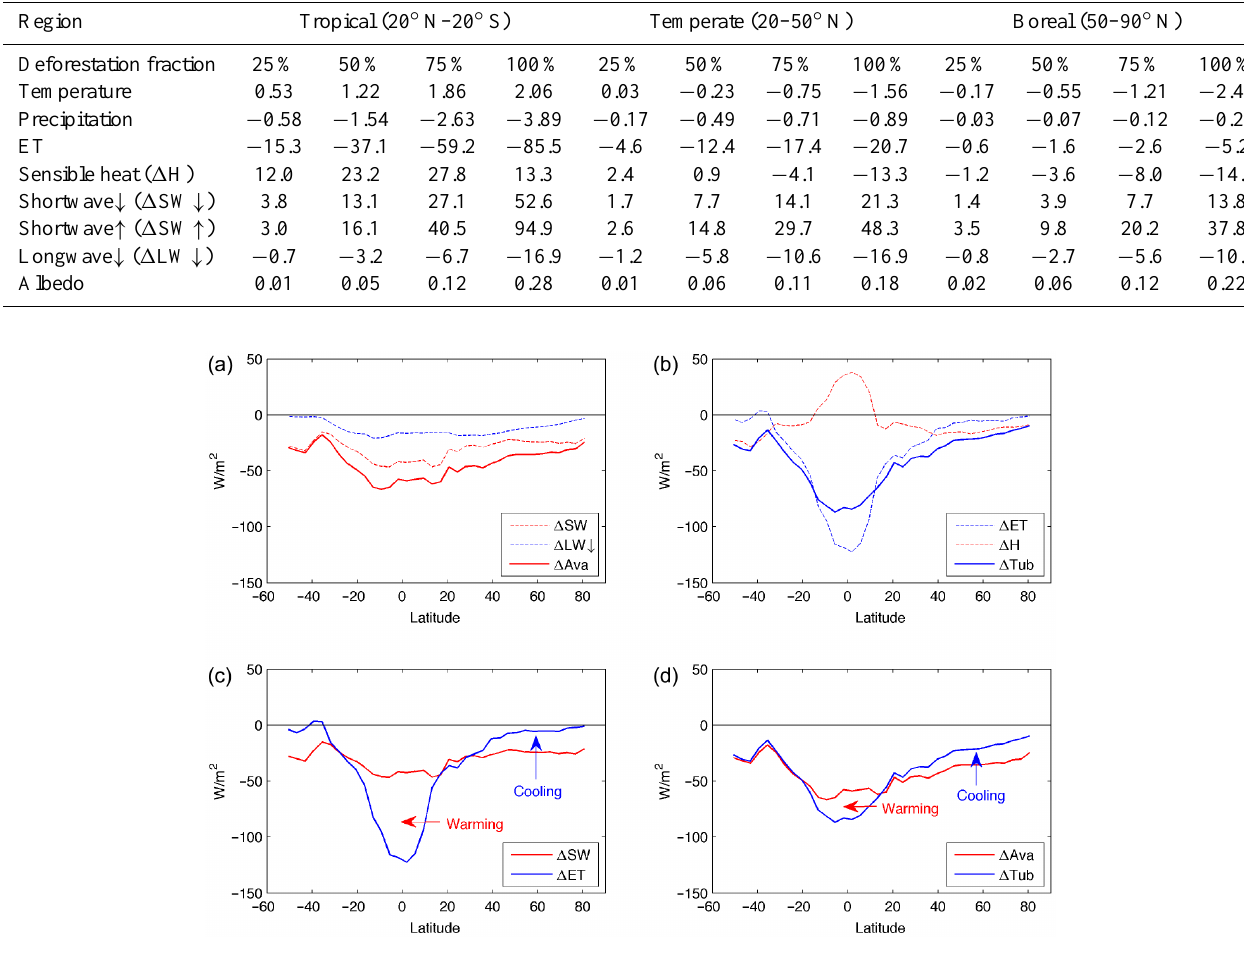
Figure 4. Latitudinal pattern of changes in surface energy balance. Panel (a) : changes in absorbed shortwave radiation ( (cid:49) SW), downward longwave radiation ( (cid:49) LW ↓ ), and available energy ( (cid:49) Ava = (cid:49) SW + (cid:49) LW ↓ ). Panel (b) : changes in evapotranspiration ( (cid:49) ET), sensible heat ( (cid:49) H), and turbulence energy ( (cid:49) Tub = (cid:49) ET + (cid:49) H). Panel (c) : (cid:49) SW and (cid:49) ET. Panel (d) : (cid:49) Ava and (cid:49)